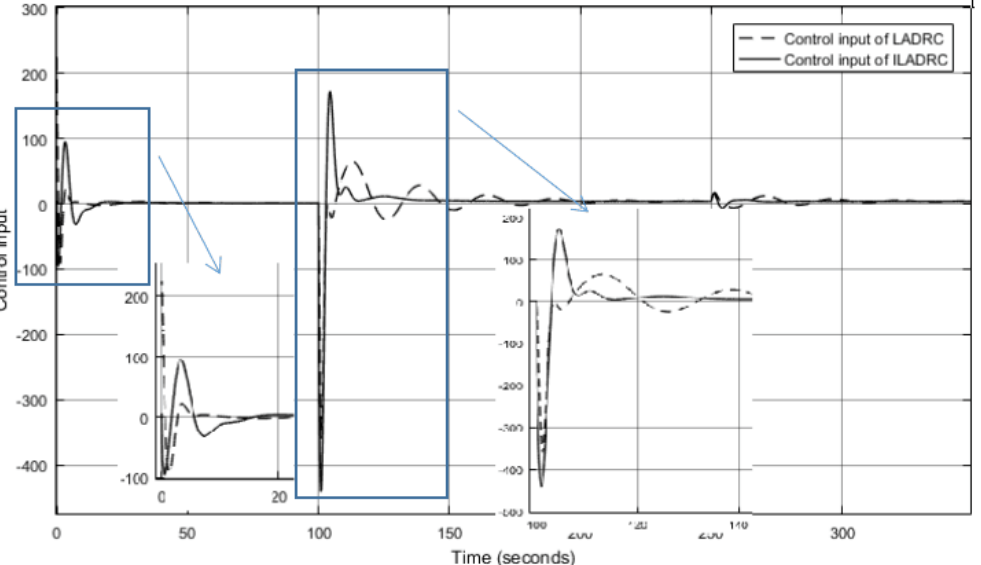
Figure 9. Comparison of control input with the model parameter G W decreasing between LADRC and